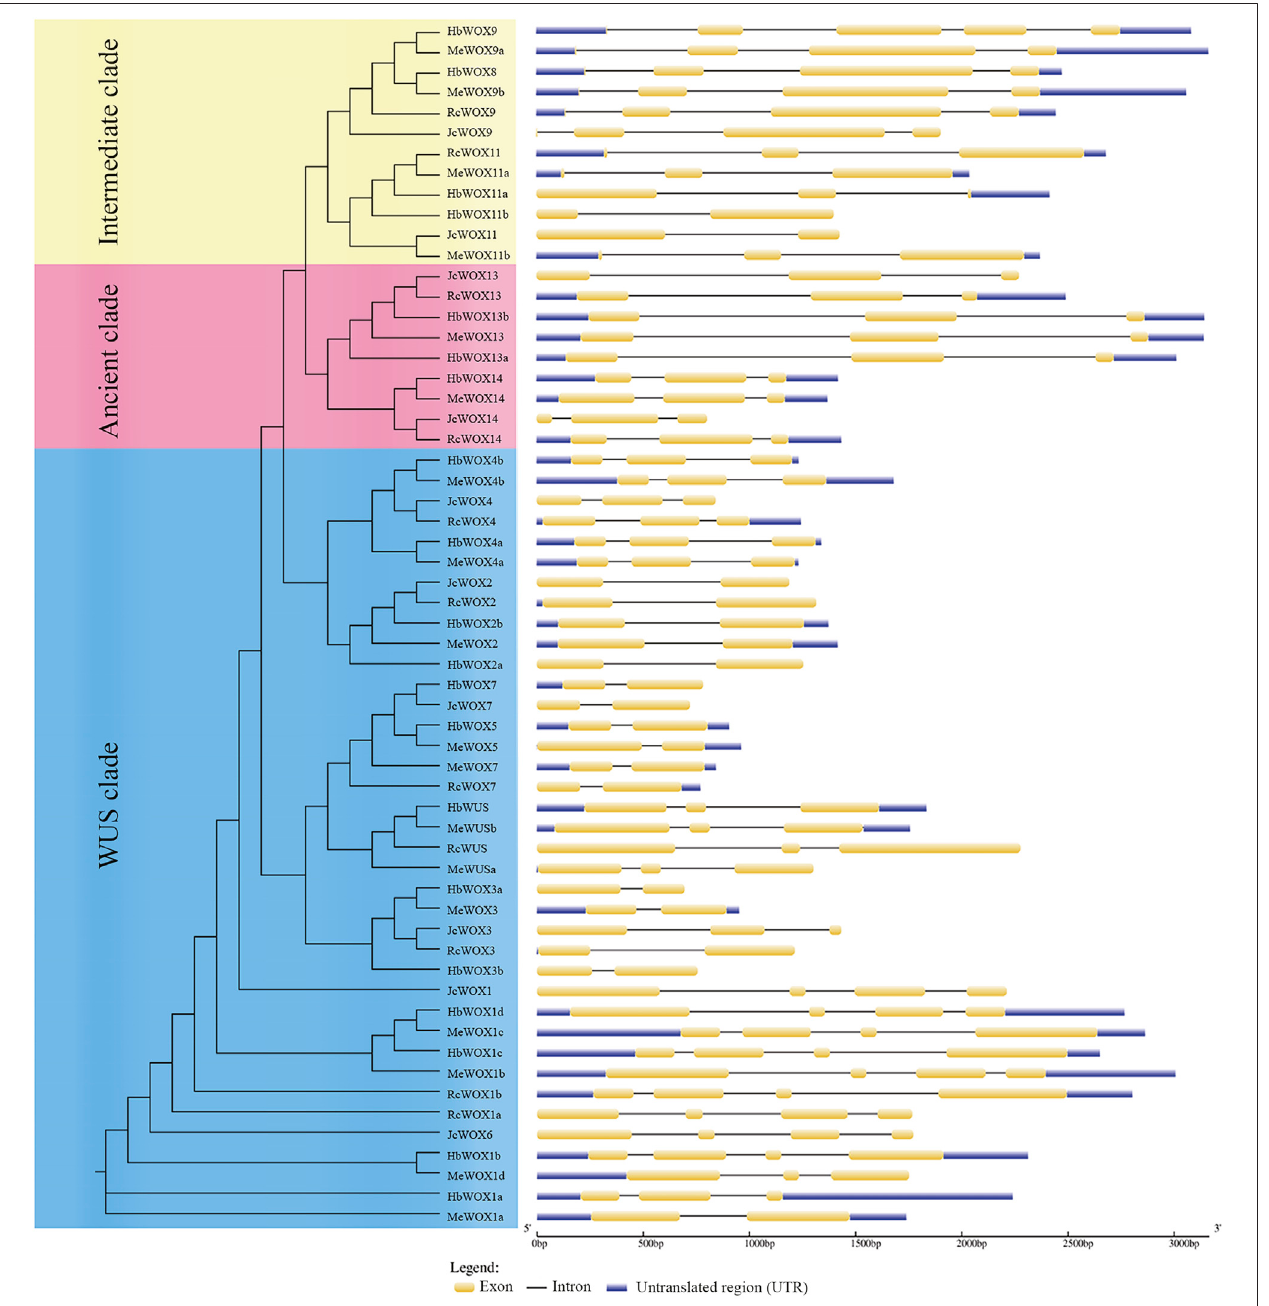
FIGURE 2 | WOX gene structure according to the phylogenetic relationship. The composition of the WOX gene includes exons, introns, and untranslated regions (UTRs).